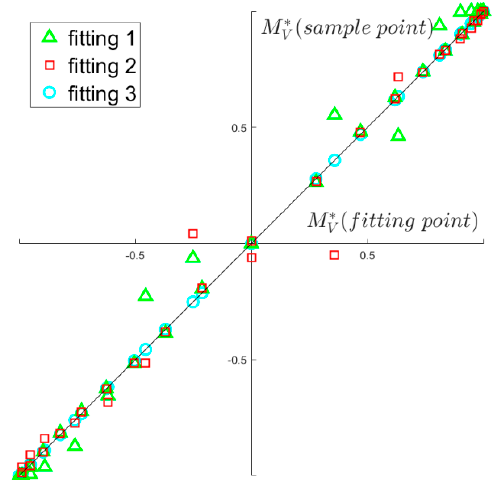
Figure 22. The case of a damaged hull due to collision.